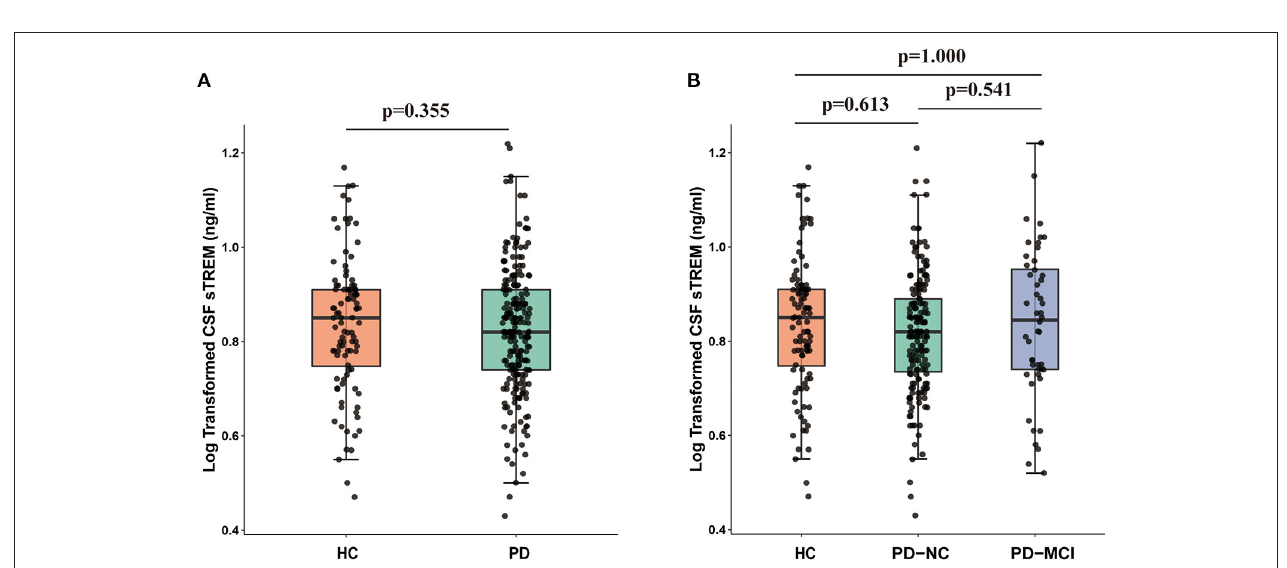
FIGURE 2 | CSF sTREM2 was not different between HC group and PD group ( p = 0.355; (A) or between HC group, PD-NC, and PD-MCI ( p > 0.05; (B) . p -values were assessed by Student’s t -test between two groups and one-way ANCOVA with Bonferroni corrected post-hoc pairwise comparisons among three groups. CSF, cerebrospinal fluid; sTREM2, soluble triggering receptors expressed on myeloid cells 2; HCs, healthy controls; PD, Parkinson’s disease; NC, normal cognition; MCI, mild cognitive